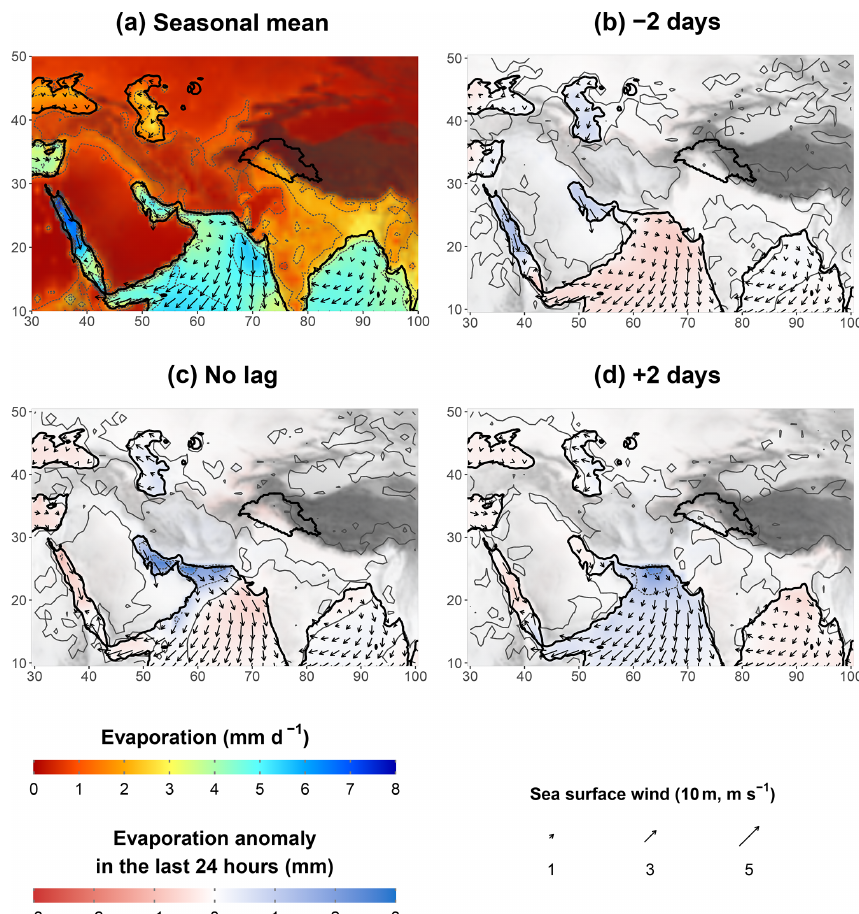
Figure 11. Panel (a) is similar to Fig. 10a but for evaporation (colour shading, thin contour lines every 5mm) and 10m sea winds (arrows). Panels (b) to (d) are similar to Fig. 10c, e, and g but for cumulated evaporation in the last 24h before the peak of UV700 plus the lead or lag indicated (colour shading, thin contour lines every 2mm) and 10m sea winds